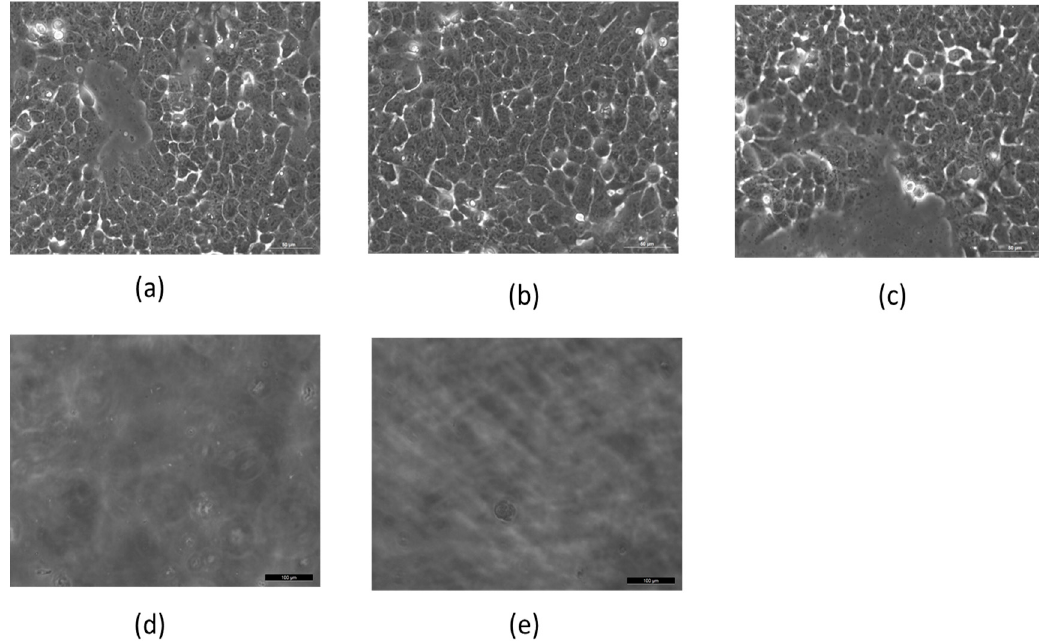
Figure 2. Cell viability of 10 6 A431 cell cultures after various treatments. ( a ) Untreated cells; ( b ) cells without magnetic nanoparticles (MNPs) treated with 15 min of alternating magnetic fields (AMFs); ( c ) cells incubated with MNPs without AMFs; ( d ) cells incubated with MNPs and treated with 15 min of AMFs; ( e ) cells with MNPs heated for 5 min on a hot plate. Imaged by Leica microscope X20.